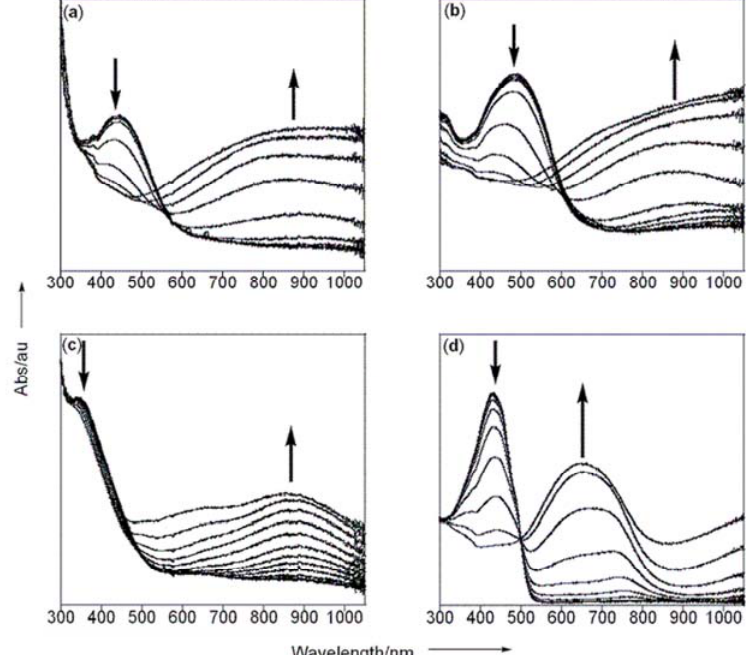
Figure 3. Spectroelectrochemical data obtained on an ITO electrode for (a) poly( MT ) between 0–1.1 V, (b) poly( MBT ) between 0–1.1 V, (c) poly( NT ) between 0–1.2 V and (d) poly( NBT ) between 0–1.3 V. Other conditions as listed in Figure 2. Figure taken